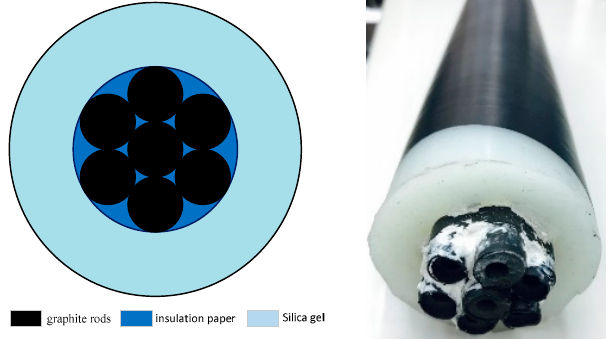
Figure 9. Structure of the cable model.